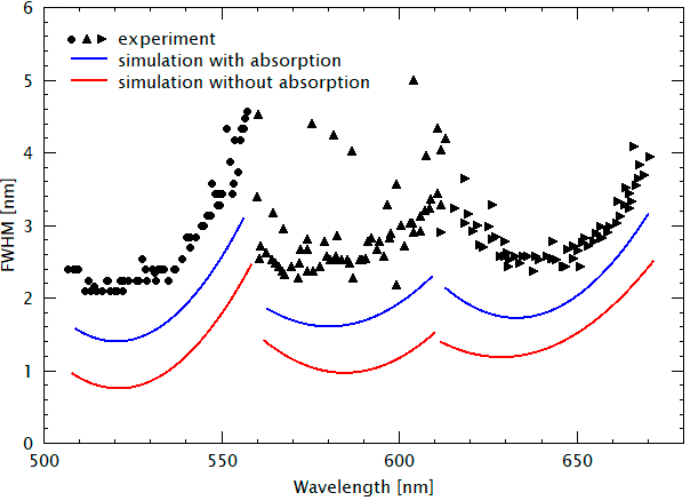
Figure 5. Comparison of measured FWHM (symbols) and simulated FWHM (full lines) of a FP filter array including 3 stopbands for the visible spectral range. The data are taken from the sample shown in Figure 4. The corresponding Transfer Matrix simulations include experimental data for spectral absorption and spectral dispersion. The symbols correspond to experimental data, whereas the full lines correspond to Transfer Matrix model simulations with consideration of the experimental data from spectroscopic ellipsometry. The blue (red) is calculated with (without) spectral absorption. For SiO 2 , the material refractive index n ranges from 1.4481 (500 nm) to 1.4358 (670 nm) and the absorption coefficient α ranges from 20.3 cm − 1 (510 nm) to 10.7 cm − 1 (670 nm). For Si 3 N 4 , the material refractive index n ranges from 1.8276 (500 nm) to 1.8019 (670 nm) and the absorption coefficient α ranges from 228 cm − 1 (500 nm) to 118 cm − 1 (670 nm). For the resist, material dispersion is considered; the material refractive index n ranges from 1.53636 (505 nm) to 1.52625 (670 nm).